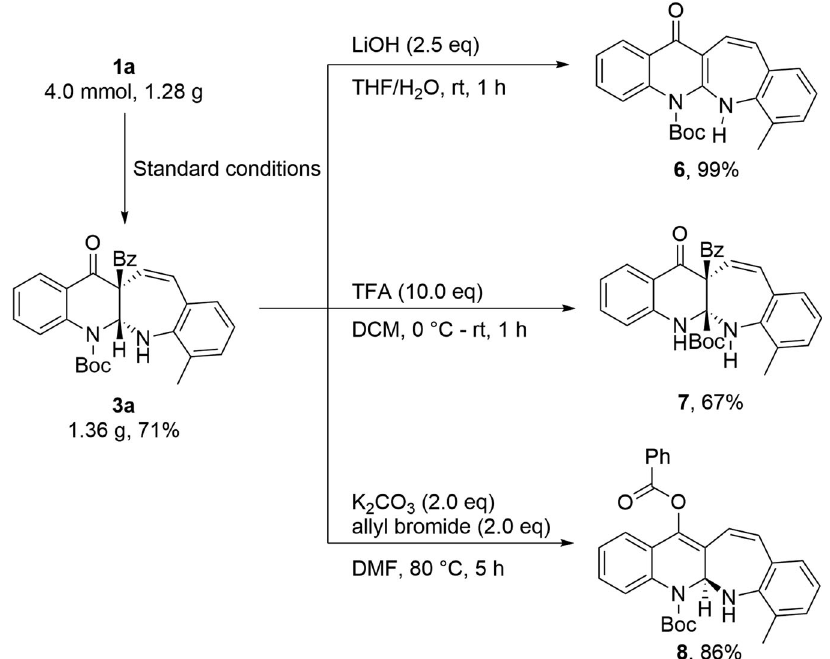
Fig. 6 Synthetic applications. The synthetic utility of the 3a was